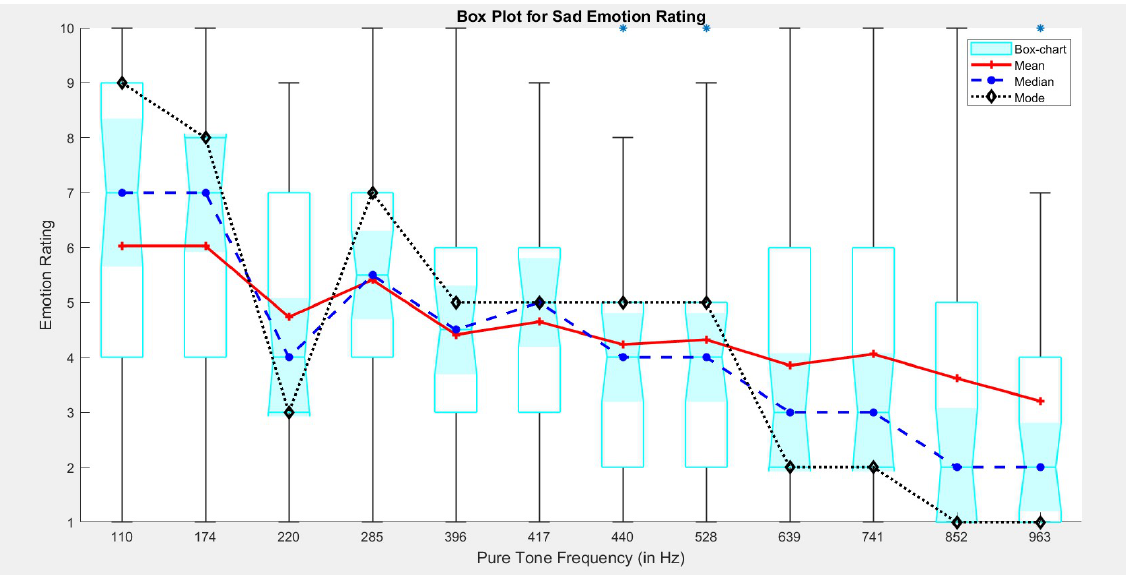
Figure 3. Plot for Sad emotion rating v/s Pure tone frequency. Here, the shaded area (cyan in color) of box chart represents distribution for annotated emotion corresponding to each pure tone